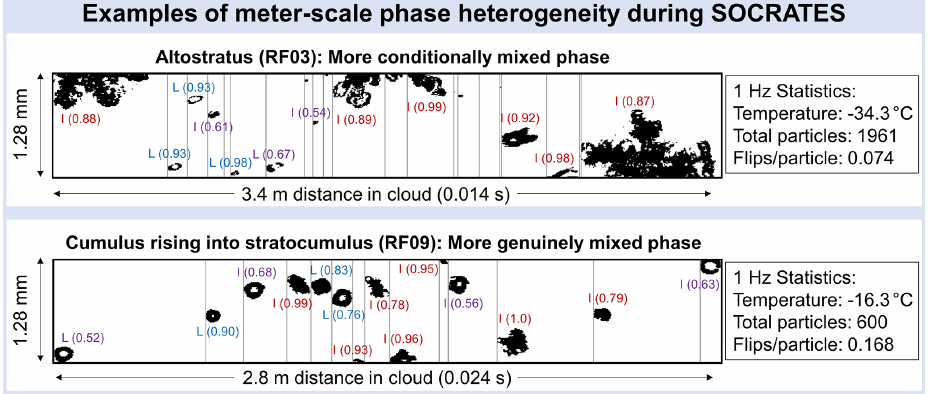
Figure 12. Short periods from two different cloud types highlight instances of meter-scale heterogeneity in the SOCRATES dataset. The photodiode dimension is vertical, and the time dimension is horizontal, which is the reverse of Fig. 9. Particle labels show UWILD classi- fications and UWILD confidences in parentheses. Red indicates ice classifications with confidences greater than 75%; blue indicates liquid classifications with confidences greater than 75%; and purple indicates ice or liquid classifications with confidences less than